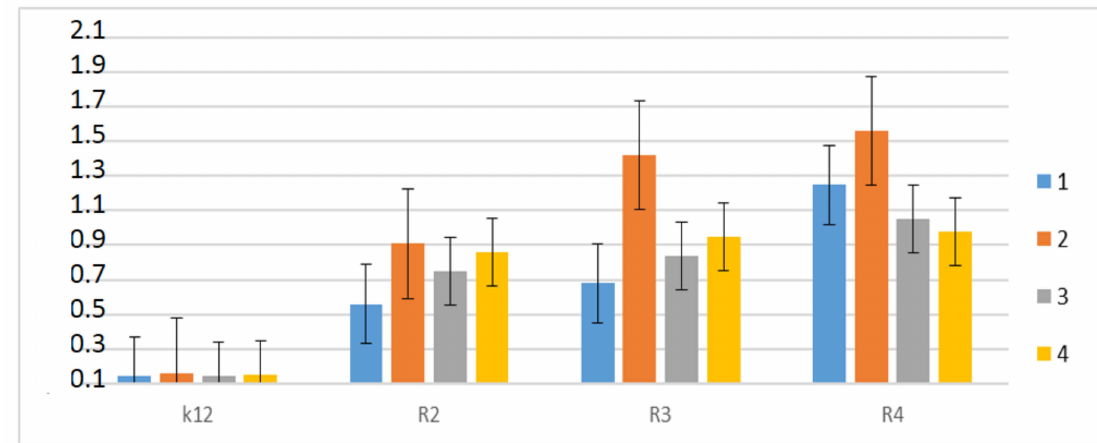
Figure 8. Examples of MIC with di ff erent strains K12, R2, R3, and R4 of the studied antibiotics with kanamycine (marked as 1-blue colour), bleomycine (marked as 2-orange colour), streptomycine (marked as 3-grey colour), and ciprofloxacine (marked as 4-yellow colour). The x-axis features antibiotics used sequentially. The y-axis features the MIC value in mM.